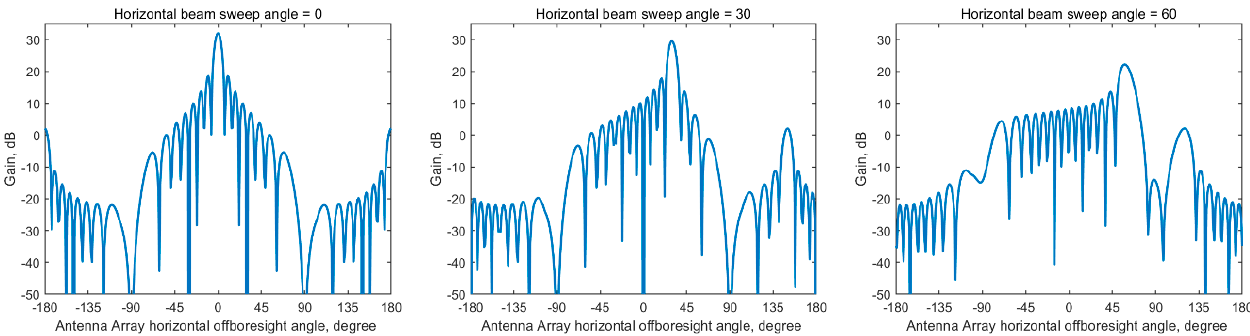
Figure 6. Antenna gains of a 16 × 16 antenna array.